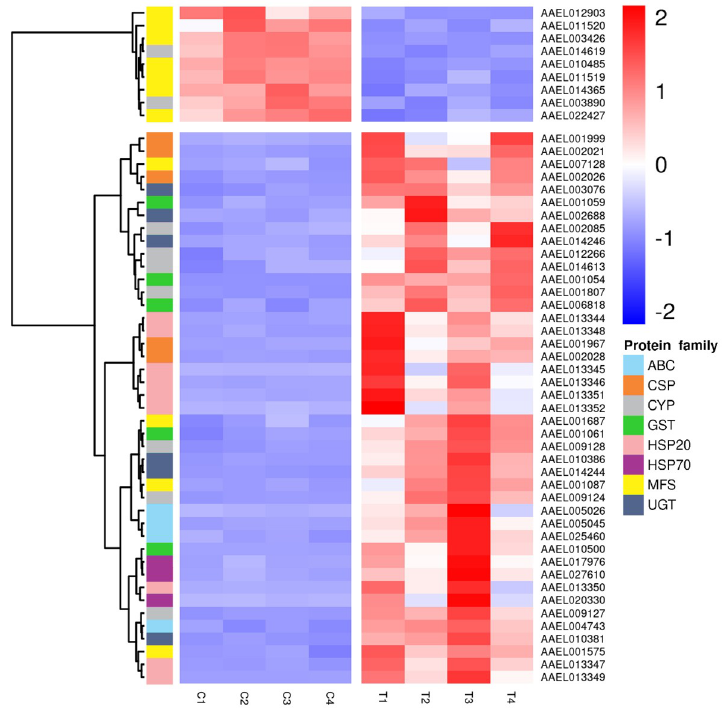
Fig 1. Effect of EEO treatment on the transcription of differentially expressed genes related to xenobiotic detoxification families and major facilitator superfamily. Heatmap was prepared using pheatmap that calculated z- score for each gene and plotted by means of a color scale, in which blue/red represent lowest/highest expression. Genes are identified by their VectorBase ID. Dendrogram was plotted with hierarchical clustering among samples and genes based on Euclidean distances and Ward method for clustering. C: control samples. T: treated